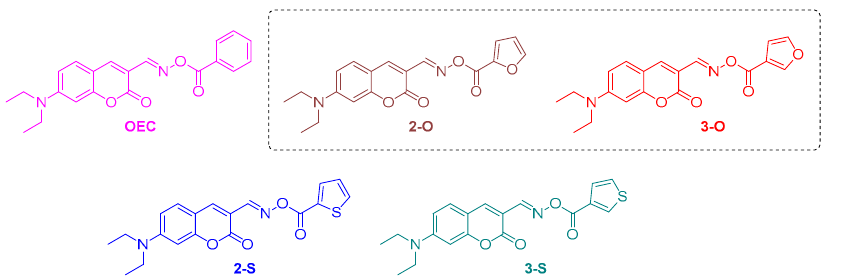
Figure 19. Chemical structures of coumarin-based oxime esters investigated by Dietliker and coworkers [191].